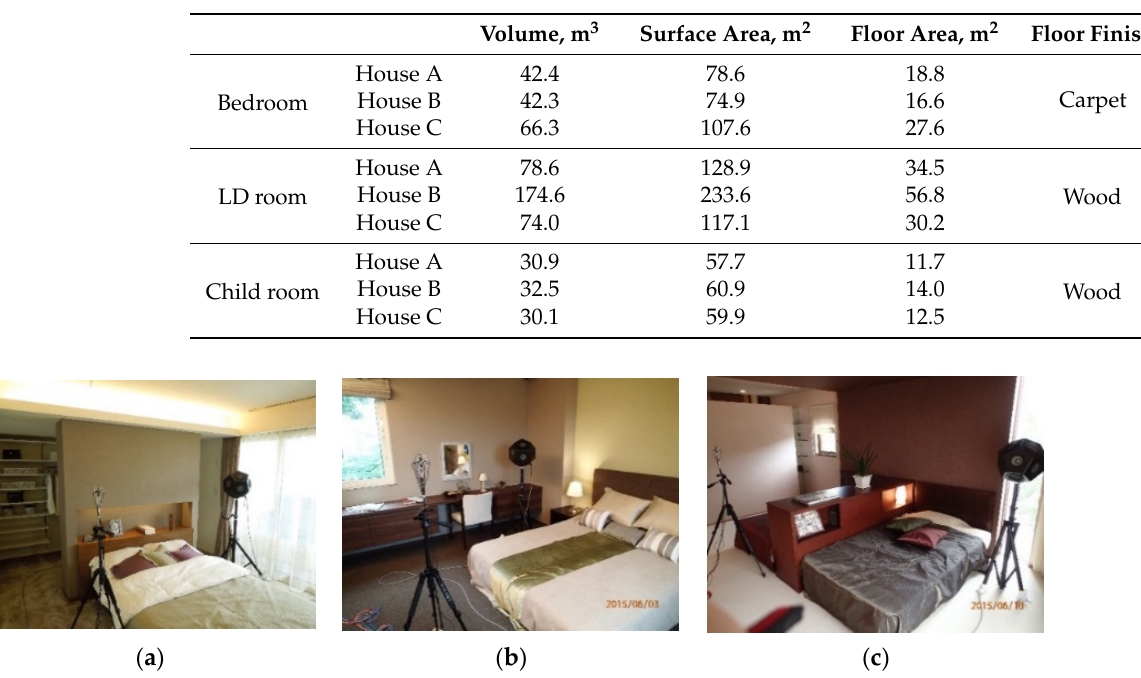
Figure 8. Measurement of impulse response in the three bedrooms: houses ( a ) A, ( b ) B, and ( c ) C.